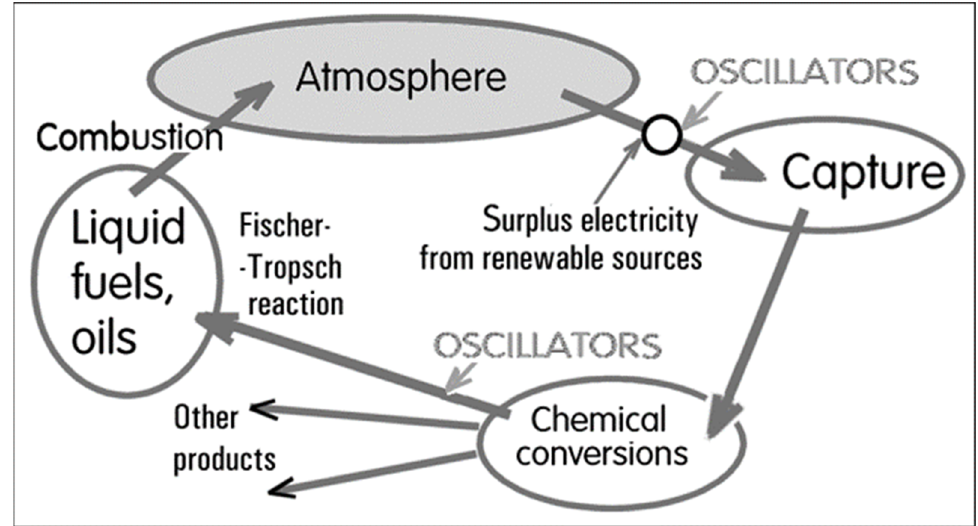
Figure 12. Potential closed-cycle solution of the problem of carbon in the atmosphere: Microbubbles mediated by fluidic oscillators can provide CO 2 capture as well as its use in reactions generating combustible products.